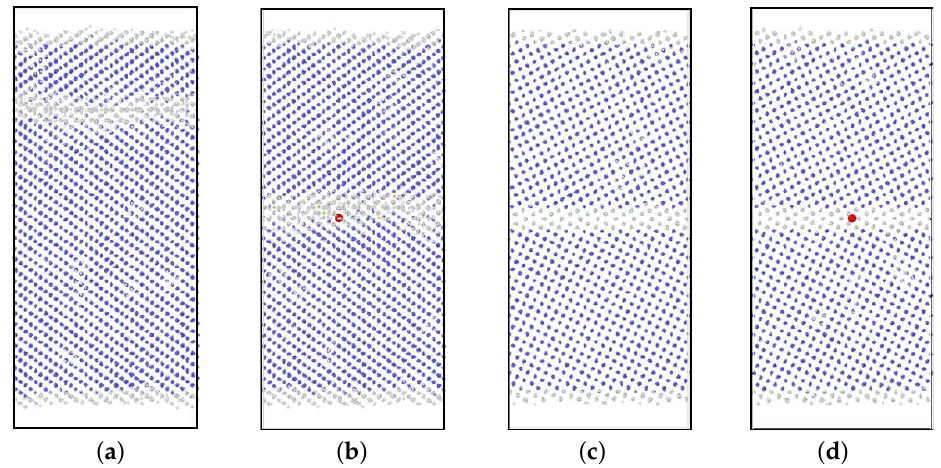
Figure 7. Effect of a P atom on the thermal migration behavior ( a , b ) of Σ 3 GB and ( c , d ) of Σ 5 GB at 800 K: These figures show the atomic state at 2.8 × 10 − 2 µ s. The meaning of the particle’s color is the same as that in the Figure 6 except the particles in the top and bottom parts. These parts are the surface region because the vacuum region was set at the top and the bottom of the simulation